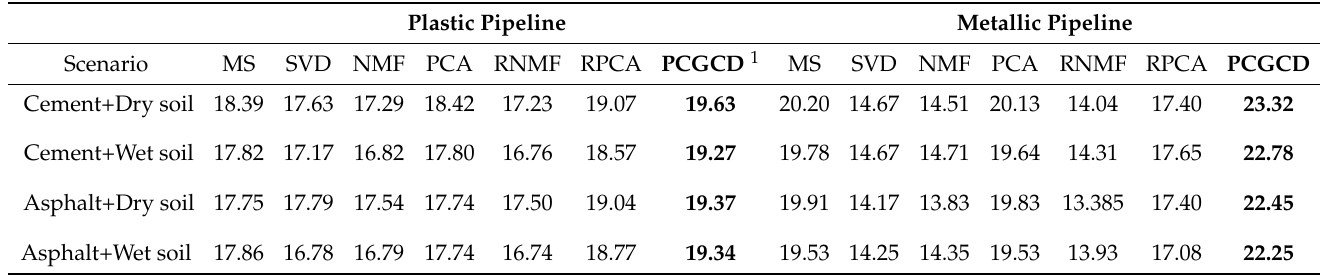
Table 2. PSNR (dB) results for the plastic and metallic piplines buried in different scenarios.